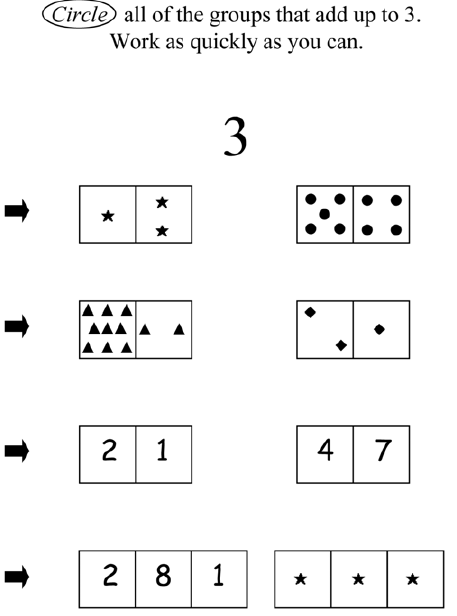
Figure 1. Practice items from the number sets measure. The task is to circle rectangles that contain collections of objects, Arabic numerals, or a combination that match a target number. For the actual task, children had 120 sec to identify which of 72 items matched a target of 5, and 180 sec for a target of 9.